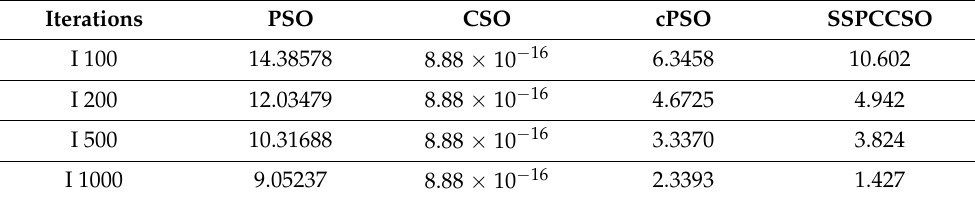
Table 6. The convergence results on test function 4 based on the same